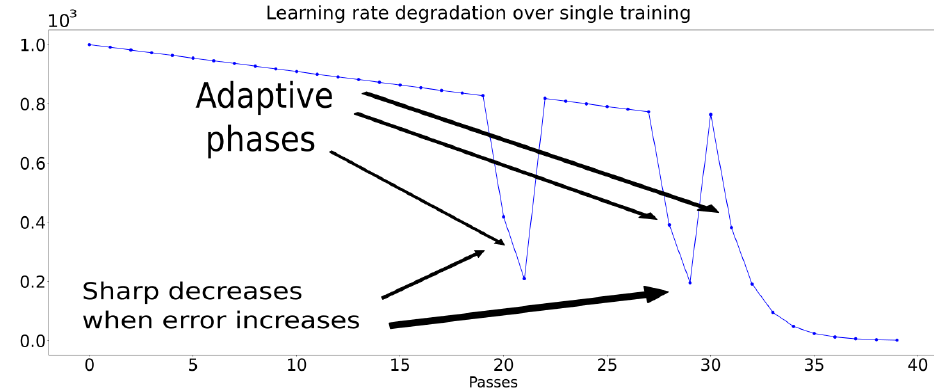
Figure 10. Learning rate degradation.